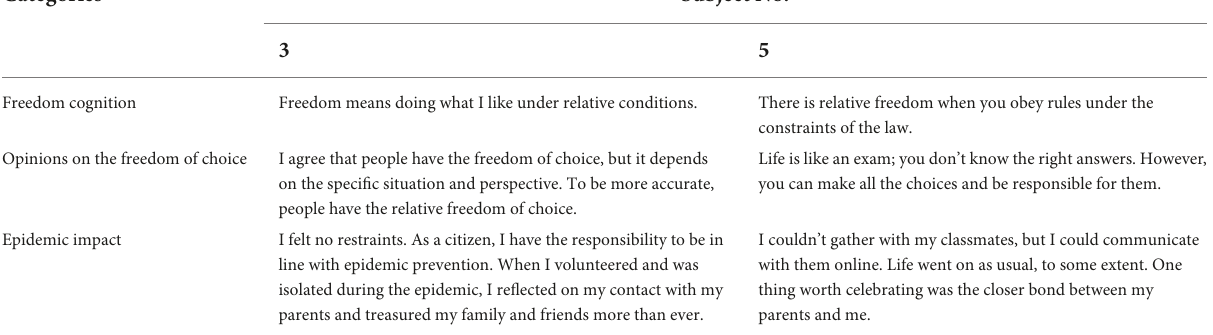
FIGURE4 Word cloud about life freedom.